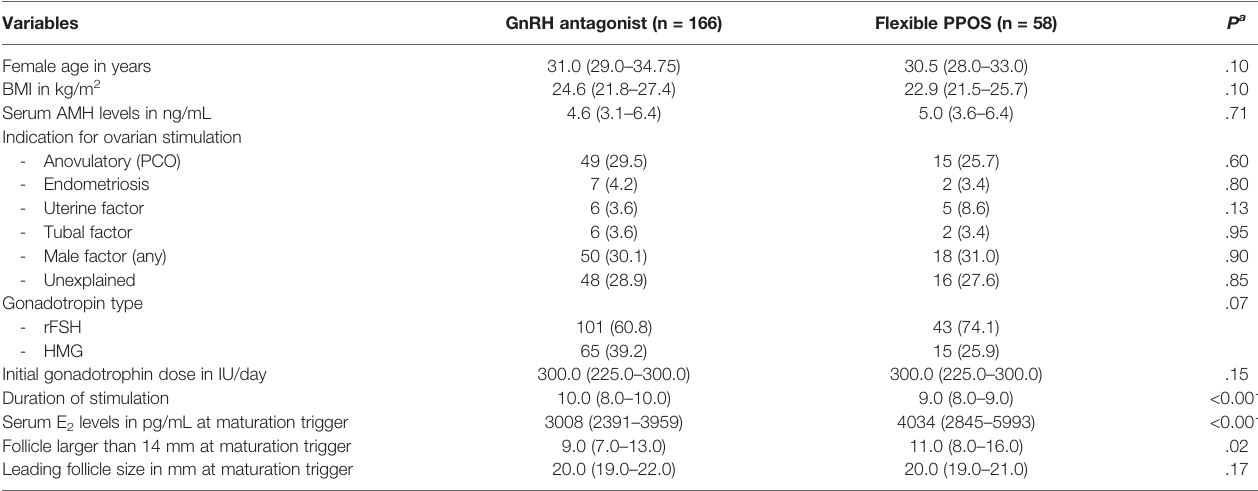
TABLE 1 | Baseline and ovarian stimulation